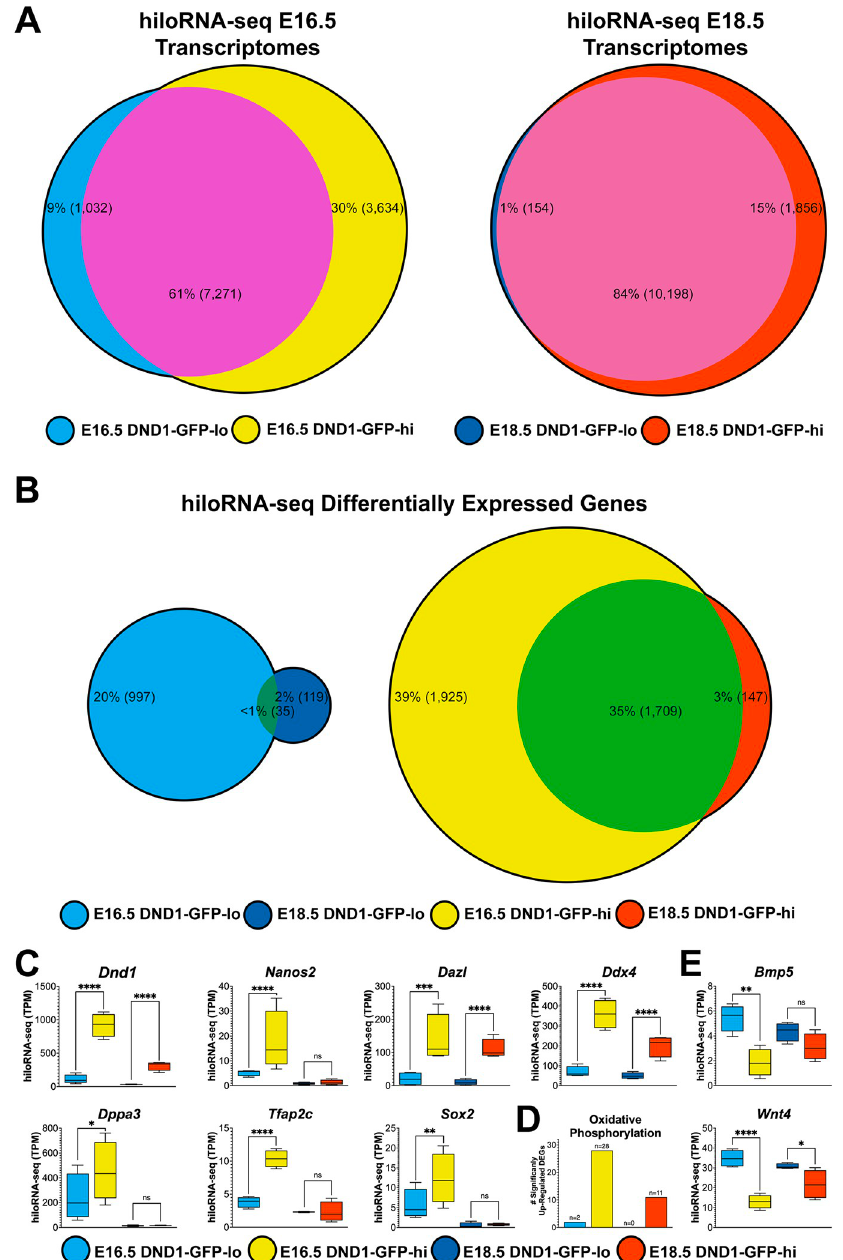
Fig 2. Although the germ cell transcriptome is mostly shared between DND1-GFP-lo and DND1-GFP-hi cells at E16.5 and E18.5, the subset of significant differentially expressed genes indicate functional differences between DND1-GFP-lo and DND1-GFP-hi cells. A: Global shared (pink) versus DND1-GFP-lo (blue) or DND1-GFP-hi (yellow; red) specific expression at E16.5 and E18.5 from hiloRNA-seq analysis. B: Euler plots of E16.5 DND1-GFP-lo (blue), E16.5 DND1-GFP-hi (yellow), E18.5 DND1-GFP-lo (dark blue), E18.5 DND1-GFP-hi (red) show global shared and significant differentially expressed genes. C : Expression of Dnd1 declined between E16.5 and E18.5 but was consistently higher in Dnd1-GFP-hi cells. Other markers associated with the germline stem cell population behaved in a similar manner. D: Transcripts of genes associated with the oxidative phosphorylation pathway were elevated in DND1-GFP-hi cells. E: Examples of intercellular signaling genes that were expressed higher in Dnd1-GFP-lo cells. hiloRNA-seq expression P-value (DESeq2) between DND1-GFP-lo and DND1-GFP-hi cells at E16.5 and E18.5: not significant (ns), < 0.05 ( � ), < 0.01 ( �� ), < 0.001 ( ��� ), < 0.0001 ( ����